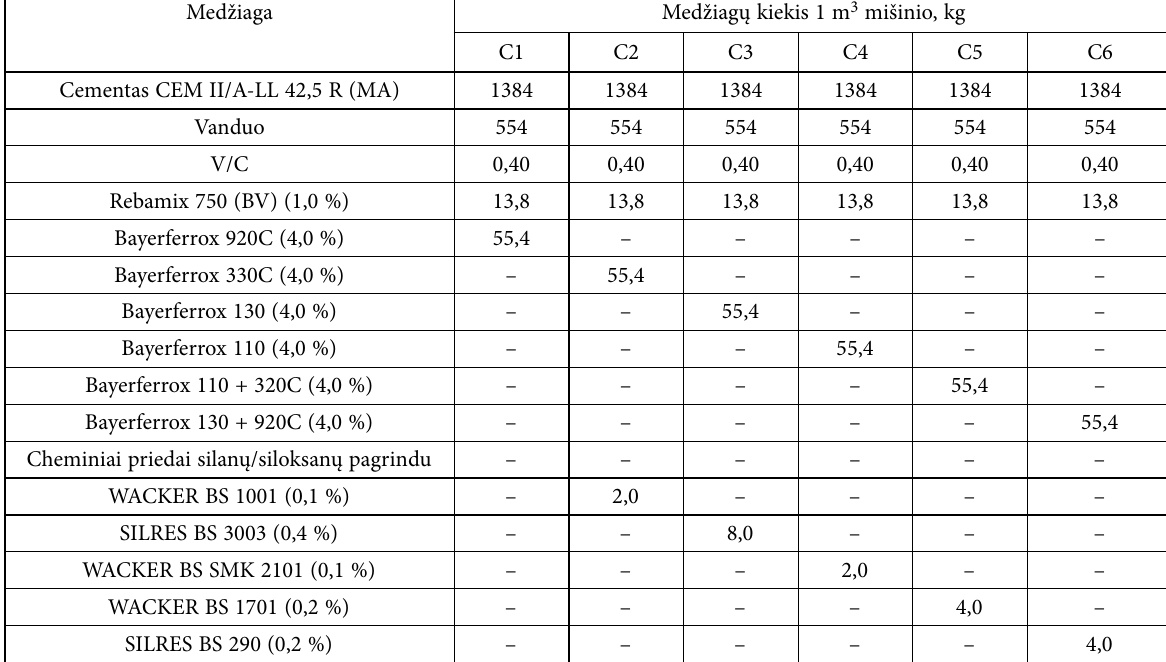
Table 3. Composition of cement